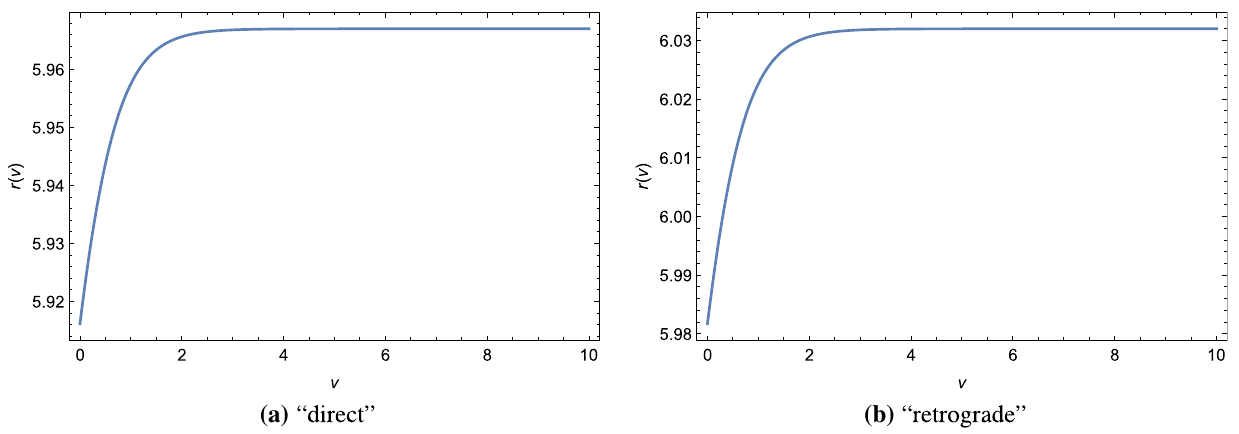
Fig. 3 The evolution of the ISCO in the slow rotation limit of Kerr–Vaidya spacetime. We have chosen the rotation parameter a = 0 .